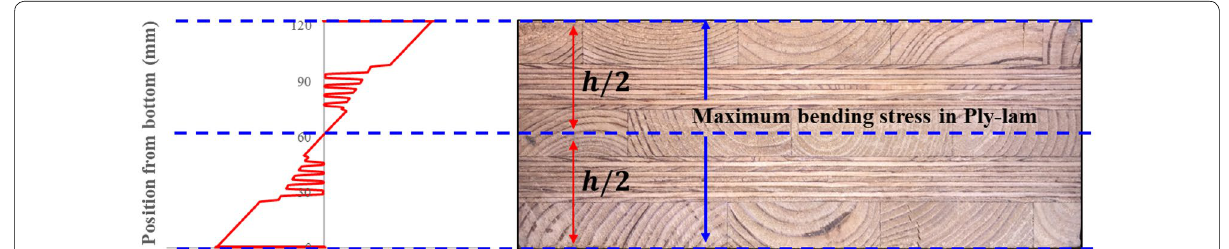
Fig. 3 Bending stress distribution to predict moment capacity of